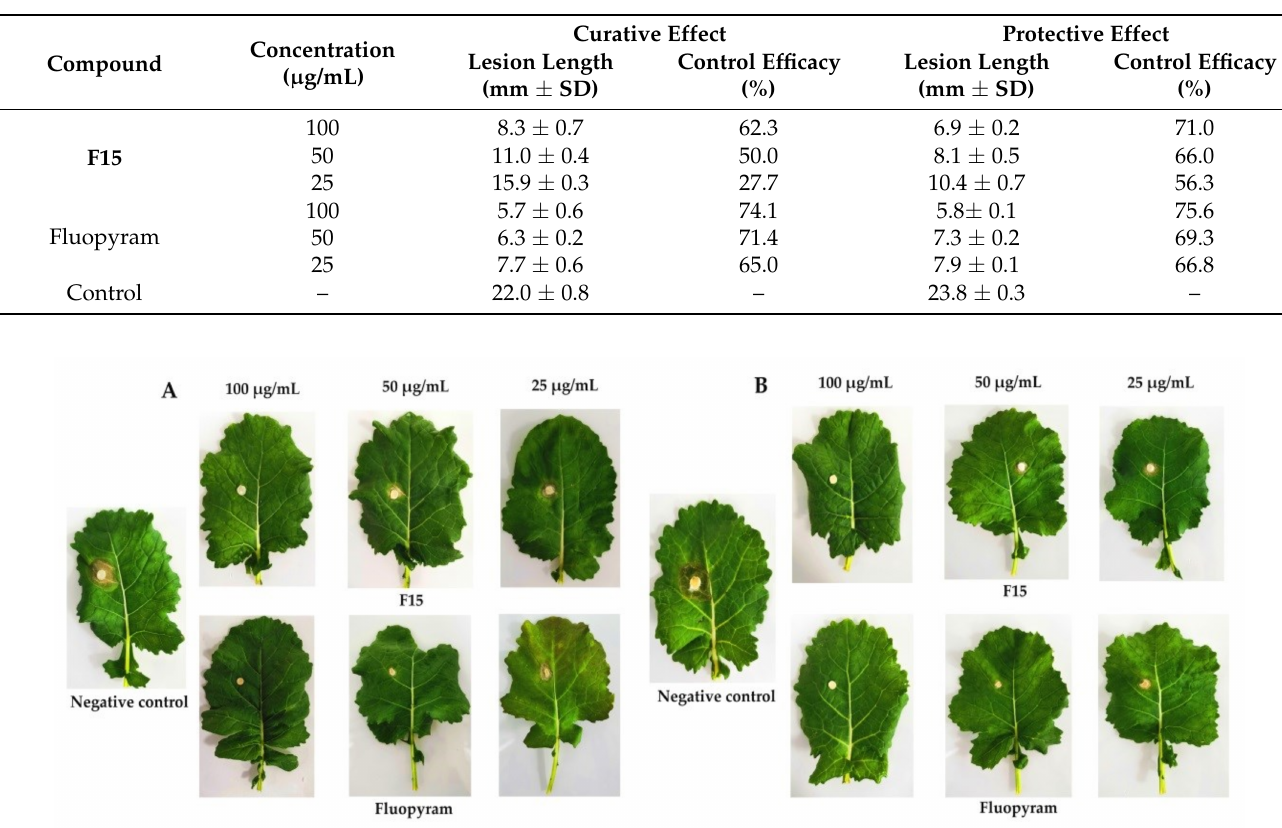
Table 3. In vivo curative and protective effects of compound F15 and fluopyram against S. sclerotiorum on infected cole leaves.